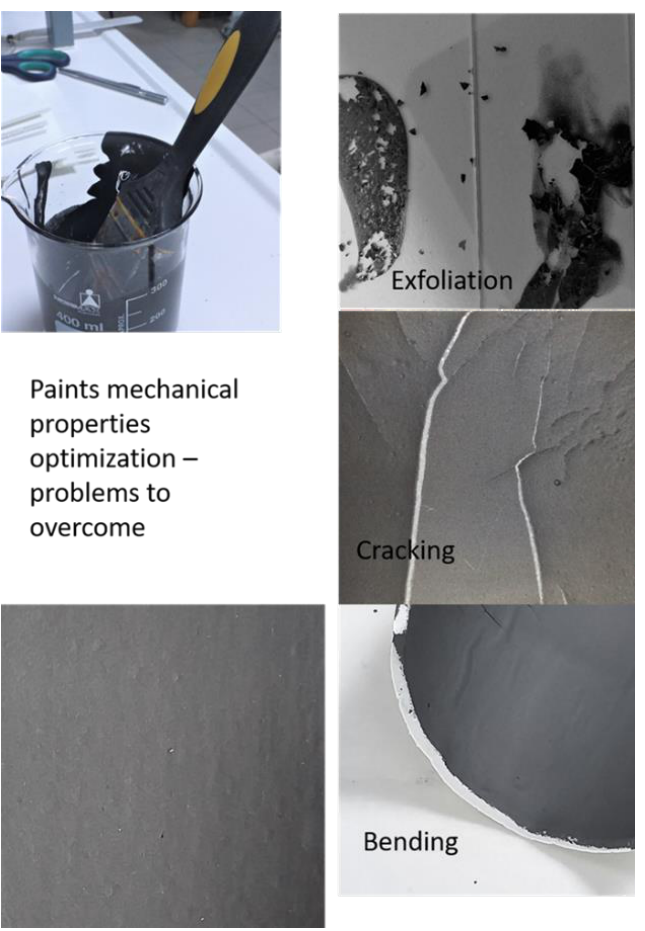
Figure 3. Steps for optimization of the paints. After the optimization of the formulation, excellent-quality coatings were obtained. Figure 4 shows some examples of large 16 × 16 cm 2 paper boards good-quality coatings used for EMI-shielding properties characterization. Then, coatings based on these optimum formulations were further studied regarding their morphology and